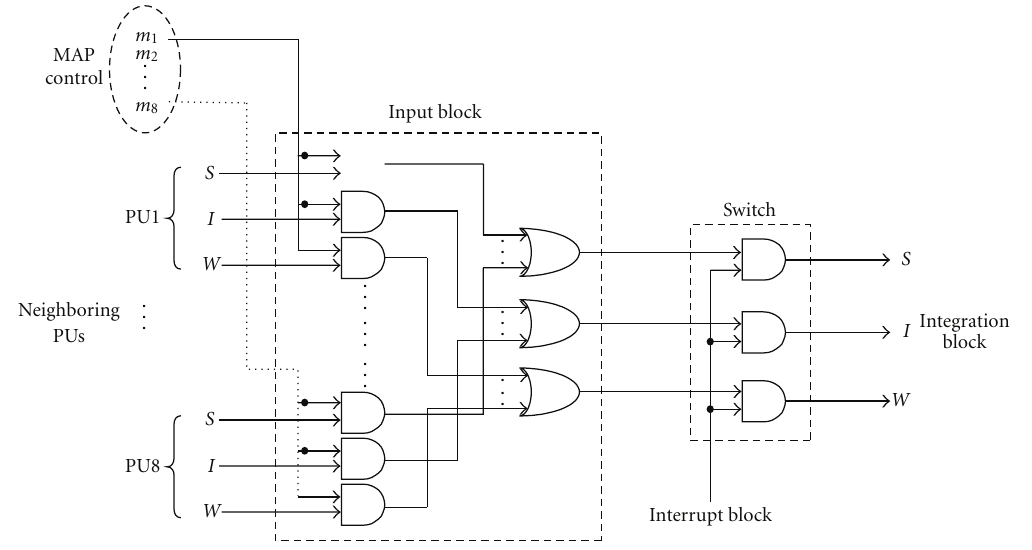
Figure 3: Conceptual architecture of the input